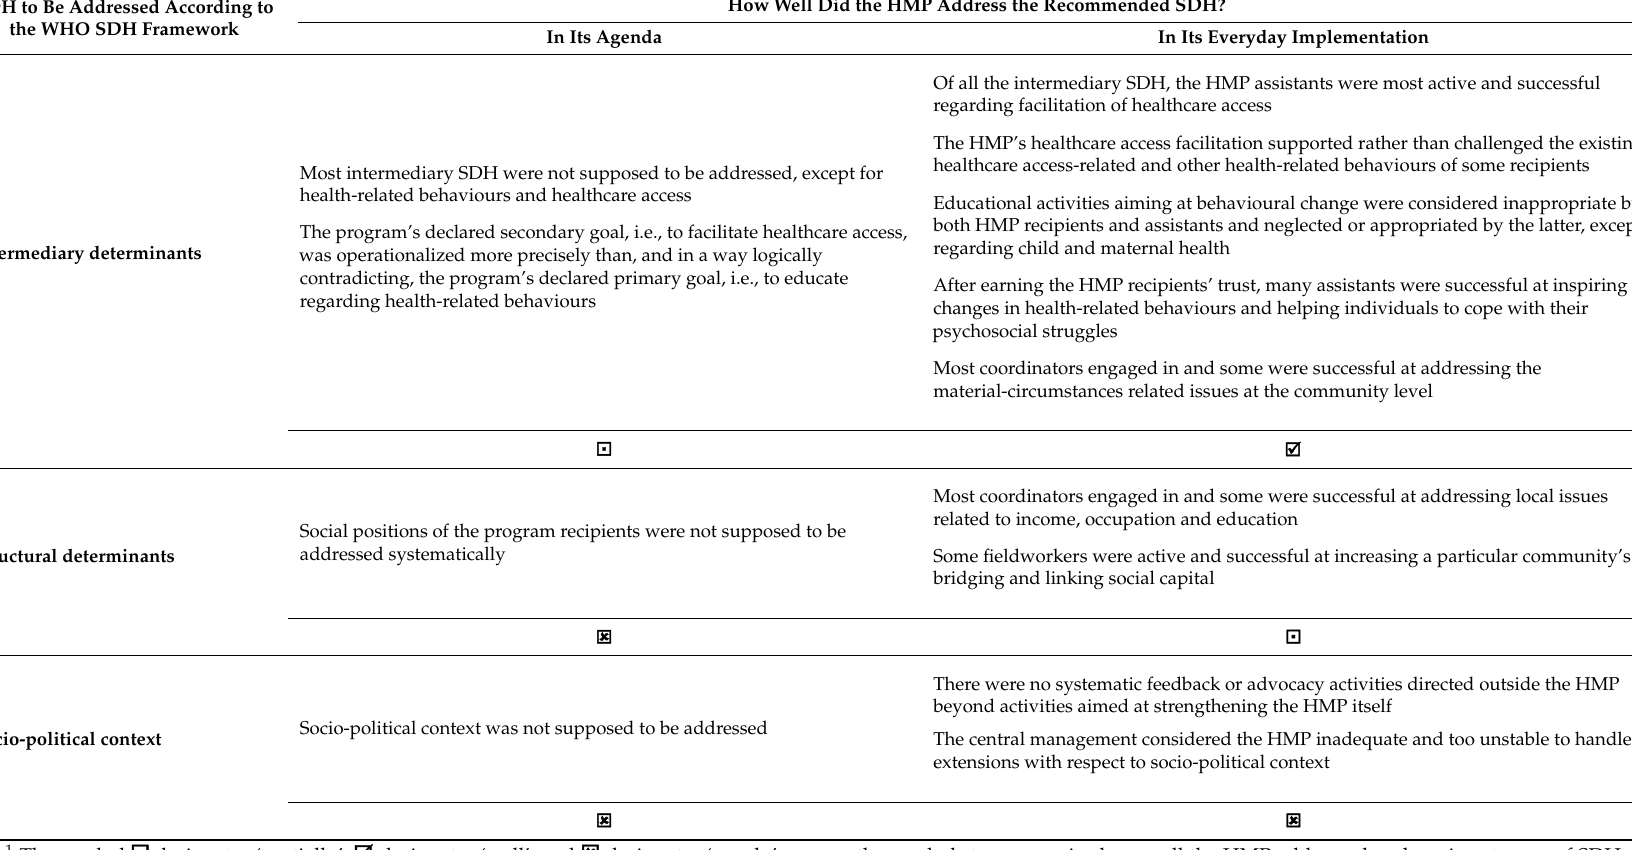
Table 2. The health ‐ mediation program’s (HMP) (in)consistencies with the World Health Organization’s Framework for action on social determinants of health (WHO SDH Framework) [18] 1 .